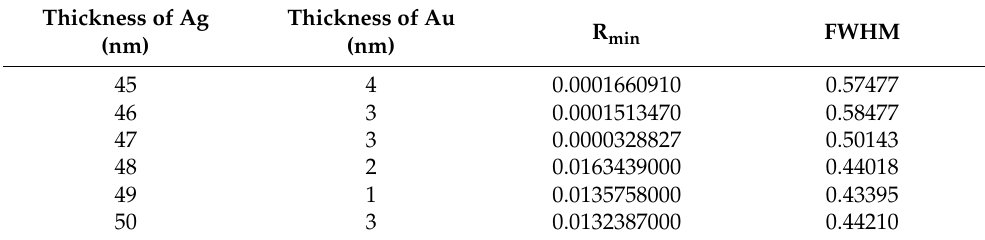
Figure 3. Reflectance of devices with the thicknesses of the silver layer at ( a ) 45 nm, ( b ) 46 nm, ( c ) 47 nm, ( d ) 48 nm, ( e ) 59 nm, and ( f ) 50 nm, and the gold layer as a different thickness. The refractive index of the sensing medium layer is 1.33. Table 1. Optimal thicknesses of the gold layers on silver layers with different thicknesses, and corresponding R min and